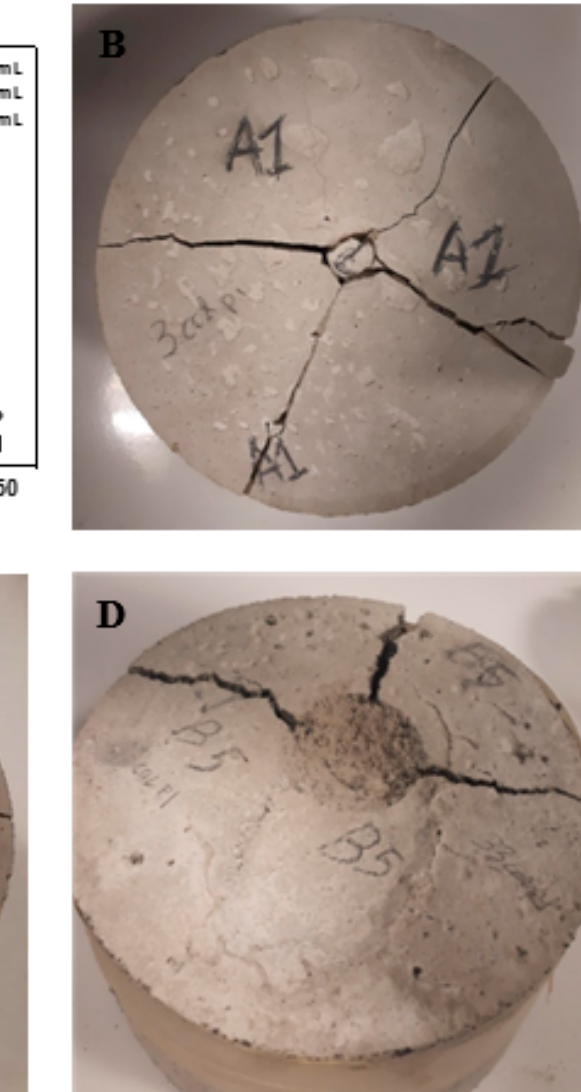
Figure 12. ( A ) Impact resistance of the TR F and perlite mortars; ( B ) P sample (sample 10); ( C ) P/TR F sample (sample 11); ( D ) TR F sample (sample 1).